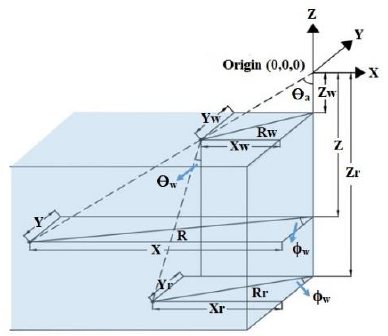
Figure 3. Schematic diagram of refraction correction applied for underwater scanning inside the 10 ft diameter pool [adapted from Smith et al.][38][31].